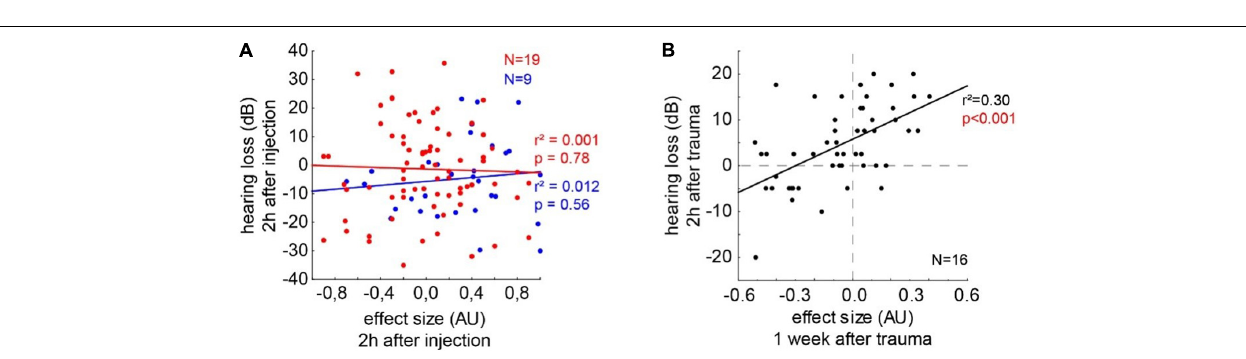
FIGURE 8 | Correlations of the behavioral and electrophysiological data by multiple linear regression analyses. (A) The separate analyses for the animals in the C and S groups are depicted with their best linear fit for the correlation of effect size and HL after 2 h post-injection. Neither in the control group ( r 2 = 0.012, p = 0.56) nor in the salicylate group ( r 2 = 0.001, p = 0.78) a significant linear regression could be found. (B) Depicts the data of the 16 animals that received an acoustic trauma at 2 kHz with 115 dB SPL over 75 min. The correlation of the HL after 2 h post trauma and the subacute effect size measured after roughly 1 week shows a significant linear regression ( r 2 = 0.30, p <